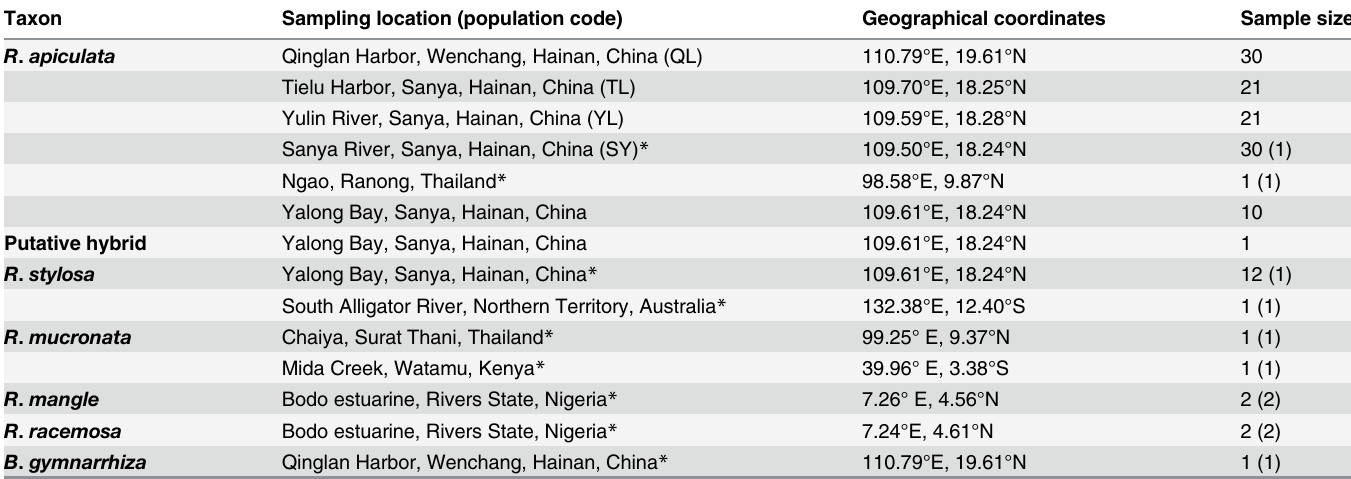
Table 1. Sampling information for the six Rhizophora taxa and the outgroup species ( Bruguiera gymnorrhiza ) used in this study.